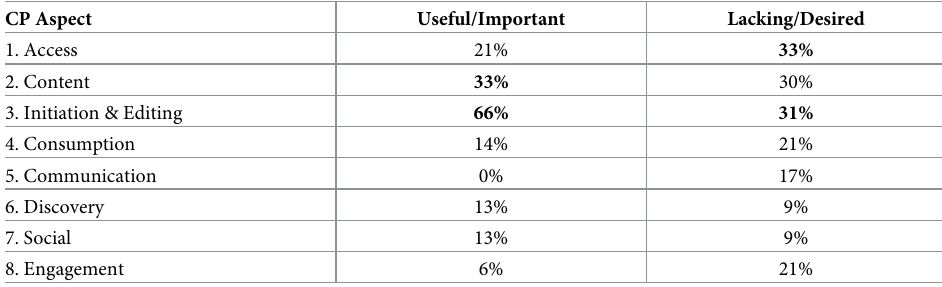
Table 2. Summary of the percentages of free-text responses mentioning each of the eight high-level aspects in the Codebook of Critical CP Factors. Bold text in each column indicates the top two categories for reported useful/impor- tant and lacking/desired